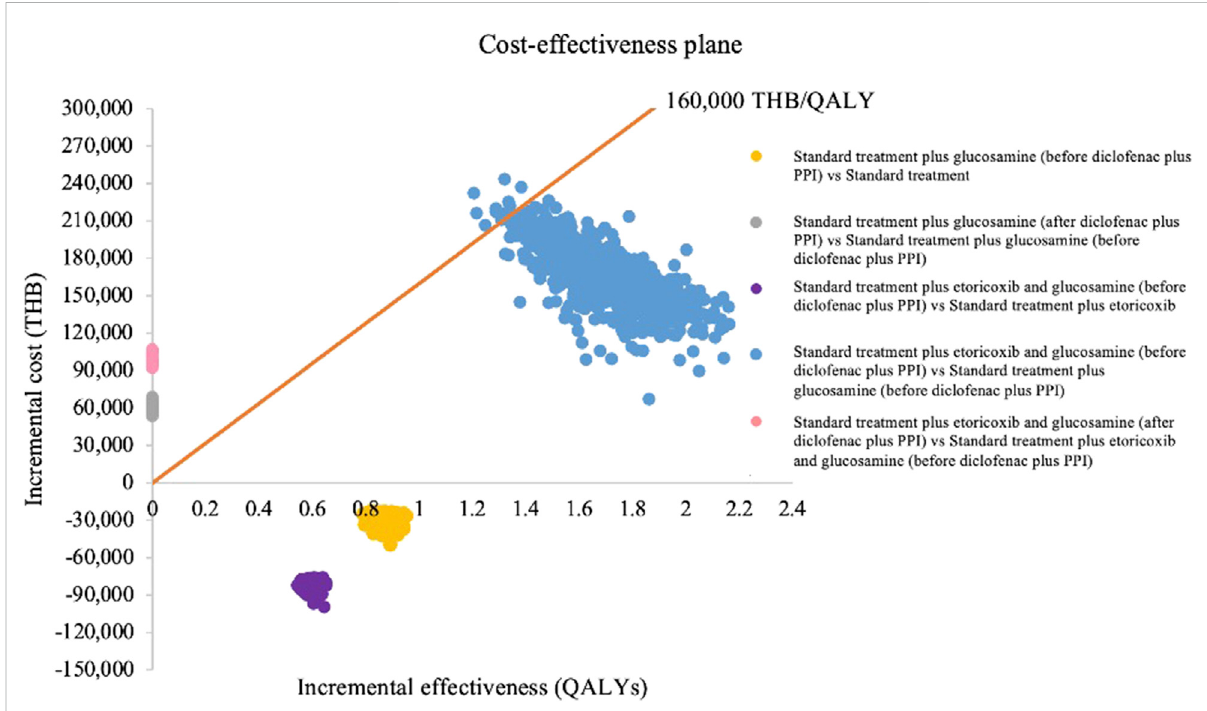
FIGURE 3 Incremental cost-effectiveness plane. PPI, proton pump inhibitors; QALYs, quality-adjusted life-years; THB, Thai Baht.